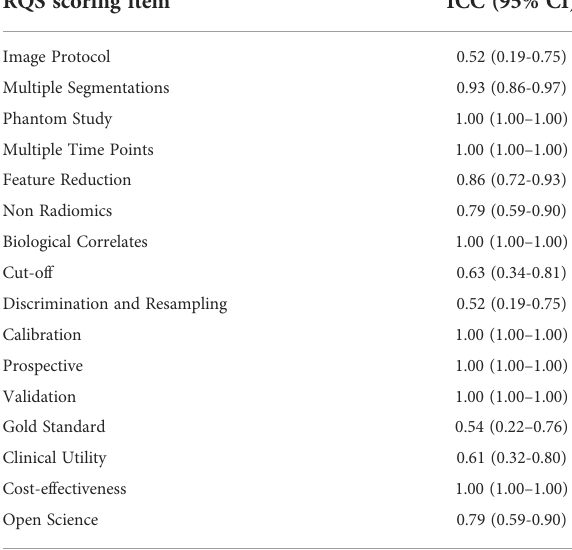
TABLE 4 Inter-rater agreement in RQS assessment.